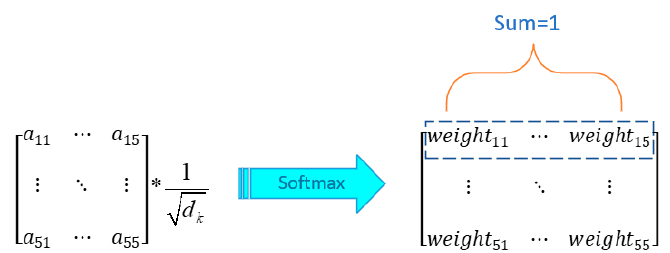
Figure 2. Weighting matrix in self-attention Figure 2. weighting matrix in self-attention mechanism. Figure 2. weighting matrix in self-attention mechanism.